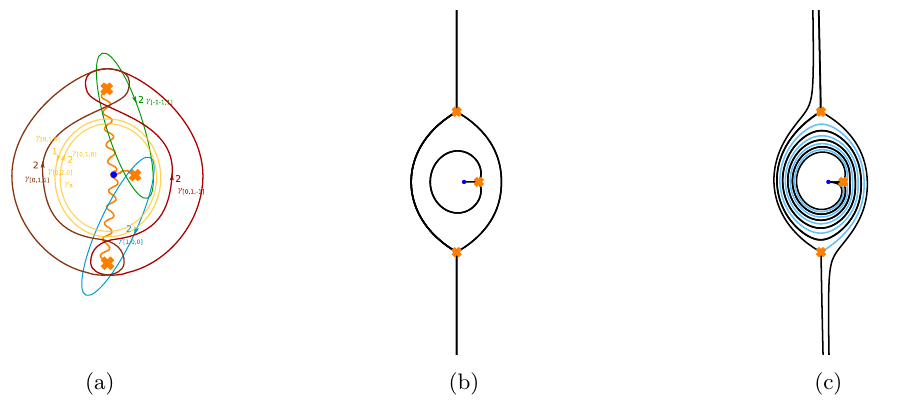
Figure 4 . In figure 4a we plot the lattice charges as loops in the z plane. The yellow double loops is γ , while the brown and red loops correspond to γ and γ . The blue loop is [0 , 2 , 0] [0 , 1 , 1] [0 , 1 , − 1] while the green loop is γ . Notice that the blue and the green loops are the analytic γ [1 , 0 , 0] [ − 1 , − 1 , 1] continuation from the charges in the strong coupling region, see figure 3. So they maintain their charge labeling. In figure 4b we show W ϑ =0 ,m =0 in the z plane. This corresponds to the degenerate spectral network for the BPS vectormultiplet γ and the 2 BPS hypermultiplets γ and γ . a [0 , 1 , 1] [0 , 1 , − 1] There are infinite many BPS hypermultiplets besides γ and γ . We can see this from [0 , 1 , 1] [0 , 1 , − 1] figure 4c which shows how the spectral network looks when we slightly vary ϑ . This spiraling walls will be more and more less spiraling when ϑ is varying away from ϑ = 0 . In this process, there will be infinite saddle connections corresponding to hypermultiplets. These infinite saddle connections correspond to the hypermultiplets γ + nγ and γ + nγ , where n = 0 , 1 , . . . is the winding a D a a [ − 1 , − 1 , 1] number of the paths inside the ring domain in figure